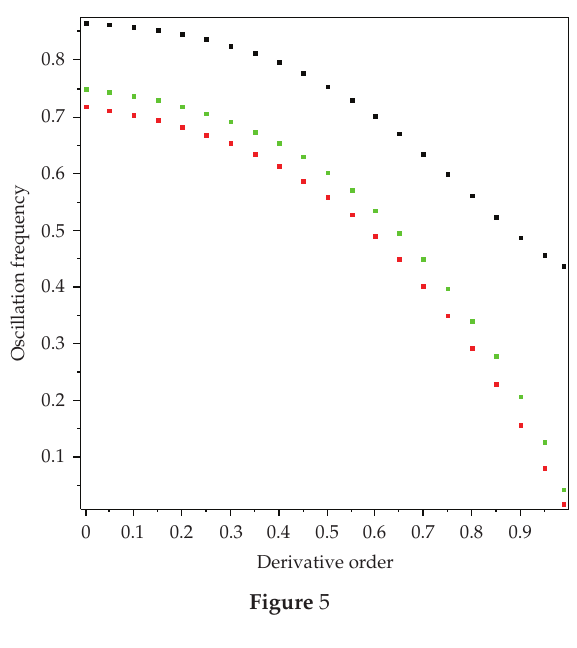
Figure 5 is a representative graph for case three, a decreasing start. The green graph is for λ (cid:4) 1 / 2 and ω (cid:4) 1 / 8, the black graph is for λ (cid:4) 1 / 2 and ω (cid:4) 1 / 4, and the red graph is for λ (cid:4) ω (cid:4) 1 /